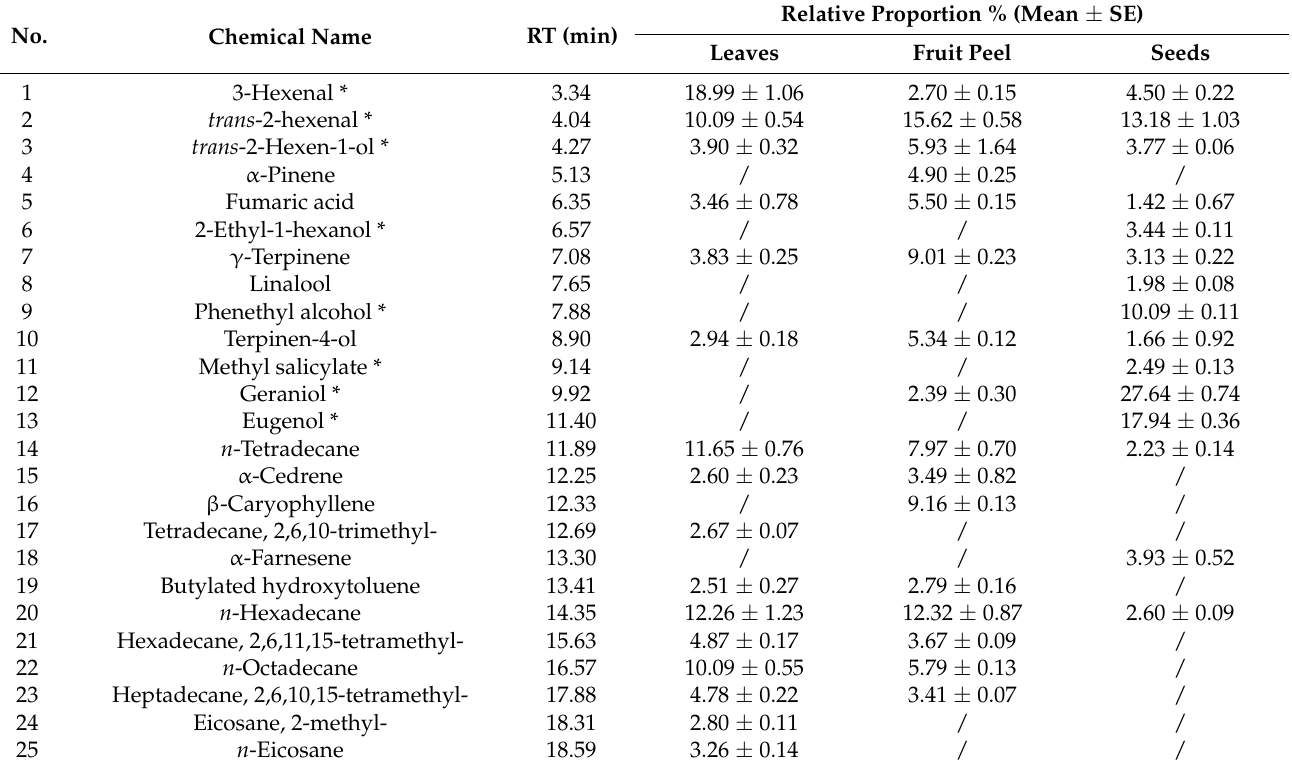
Table 1. Volatile chemicals and their relative proportions as emissions from Camellia oleifera leaves, fruit peels, and seeds (N = 3).